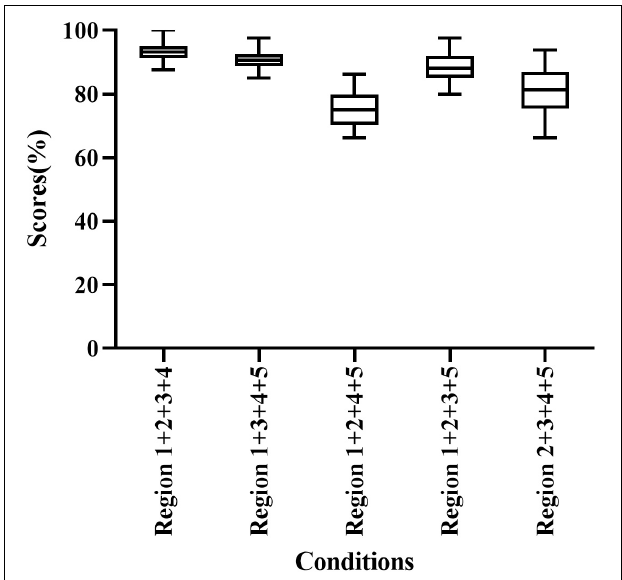
FIGURE 3 | Percent-correct scores for disyllabic word recognition using acoustic temporal envelope in four-frequency-region conditions.